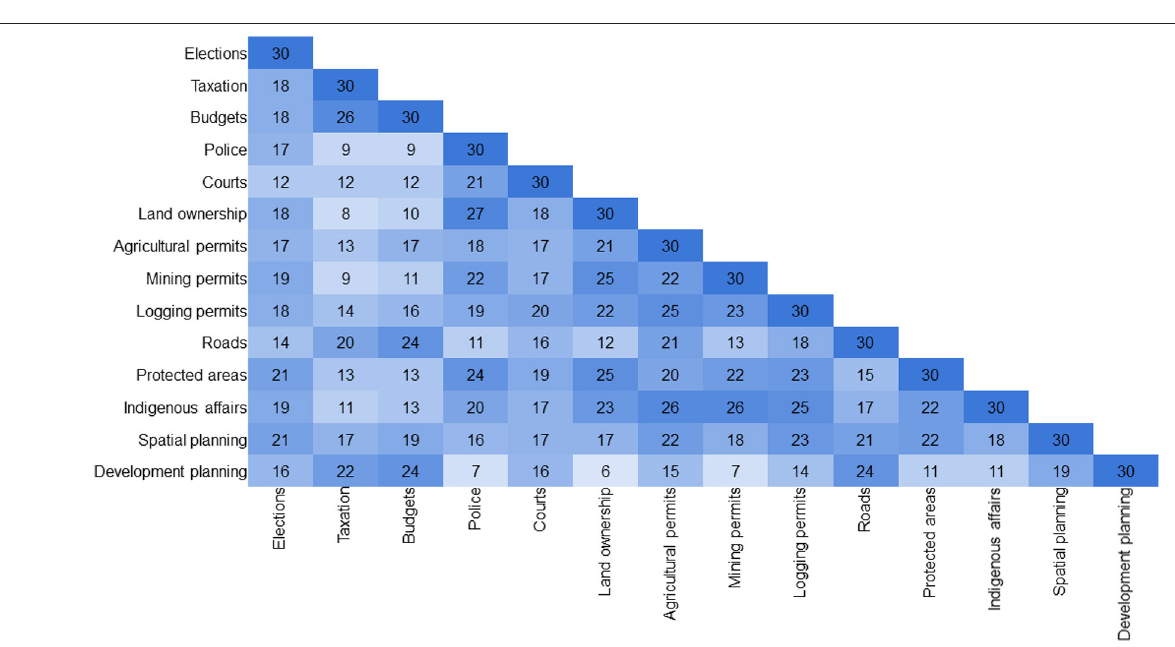
Colombia, 1 less department in Republic of Congo, and